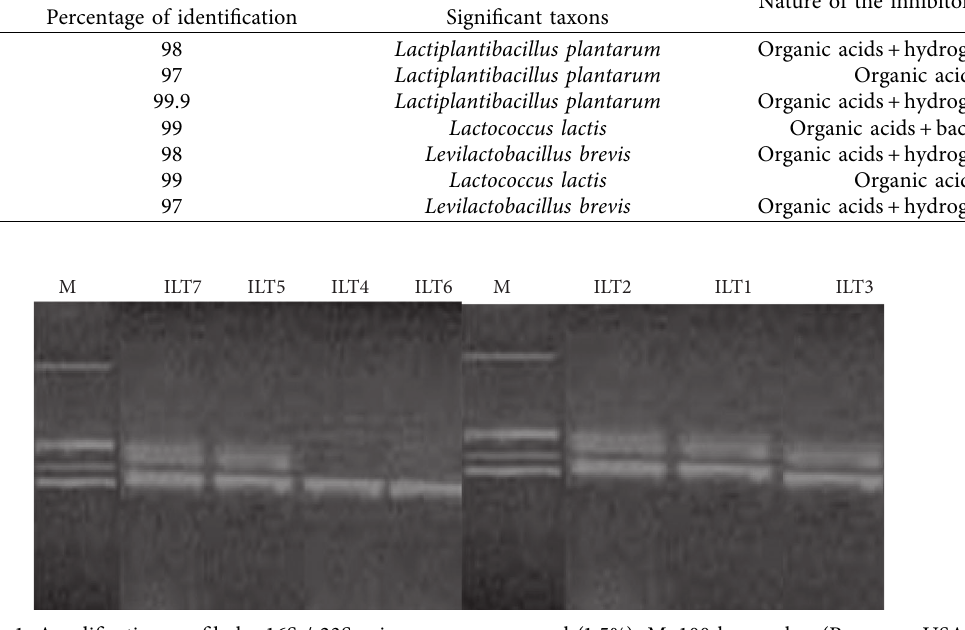
Table 1: Biochemical and molecular identification and nature of the inhibitory substance produced by selected LAB strains. LAB strains